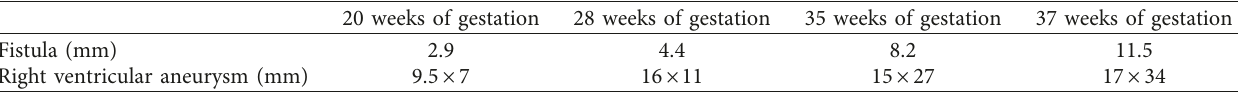
Figure 1: (a) A 4-chamber view: bizarre configuration of the right ventricle (RV), large aneurysm at the apex of the RV, and the remaining functional part, bulked myocardium. (b) Modified short axis with ascending aorta in the middle, giving rise to the giant coronary artery (LCA), which drains into the right ventricular aneurysm. (c) Entire course of the coronary artery fistula and bidirectional flow in the left coronary artery. Table 1: Prenatal echocardiography: measurements of the fistula and right ventricular